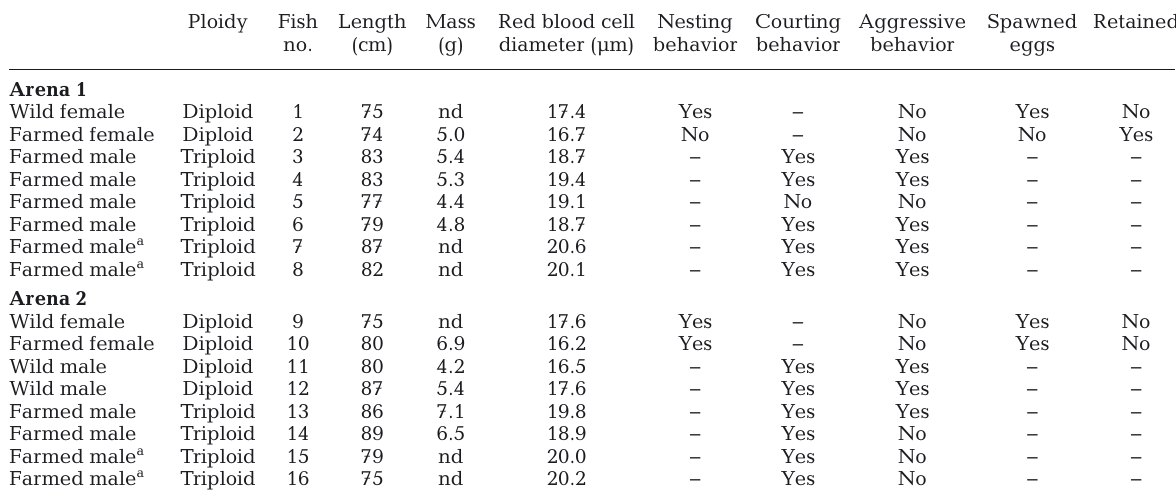
Table 1. Size and red blood cell diameters of the experimental fish, as well as a summary of their spawning behaviors, and occurrence of retained eggs in females. Male aggression in Arena 1 included long periods of fighting and biting, while the male aggression in Arena 2 was much milder and was mostly chasing and displays. nd: not determined